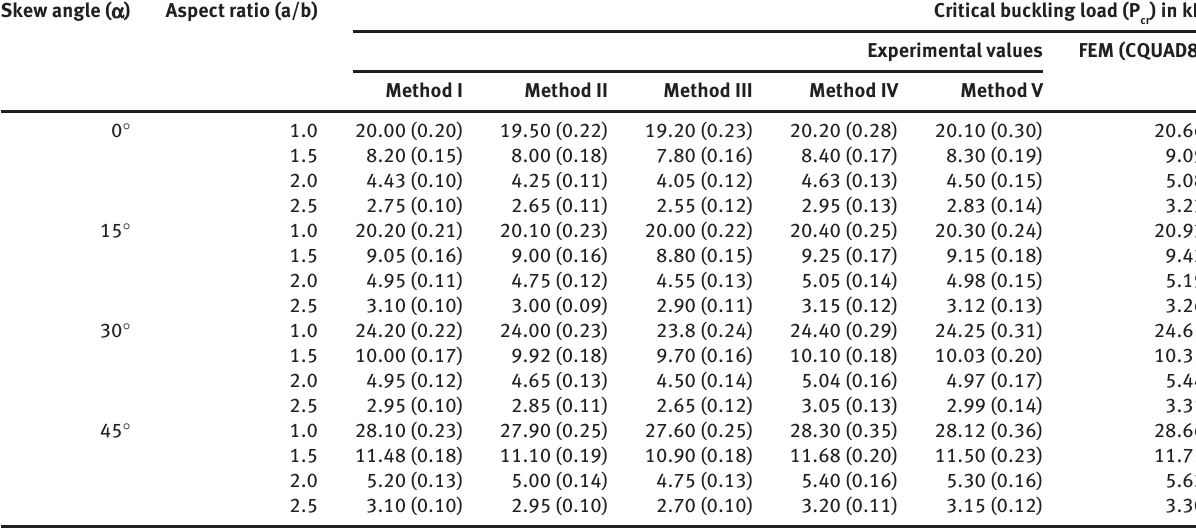
Table 1 Critical buckling load for isotropic skew plate (aluminum 7075-T6). Skew angle ( α ) Aspect ratio (a/b)